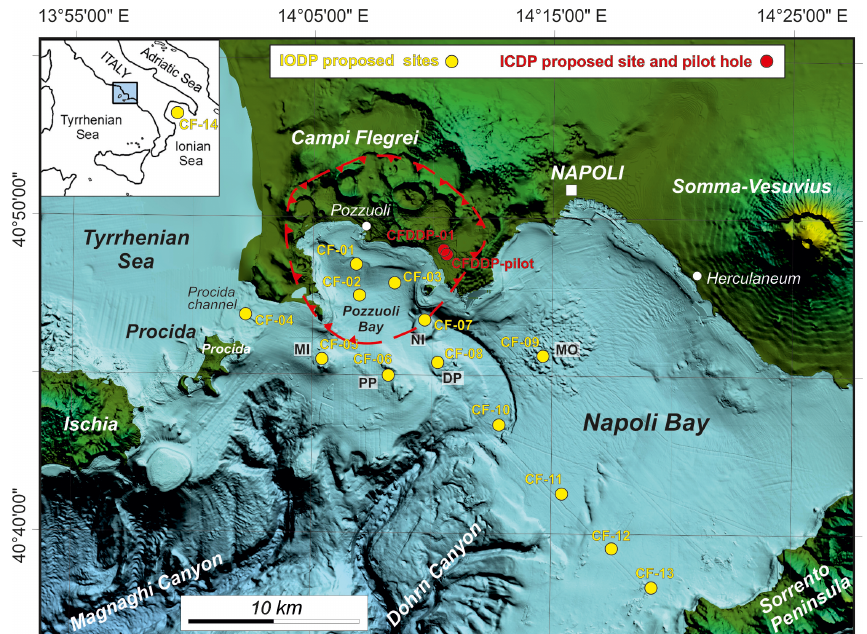
Figure 6. Location of onshore and offshore drill sites included in the first-draft plan of the Campi Flegrei Caldera Amphibious Drilling Proposal discussed during the MagellanPlus workshop.